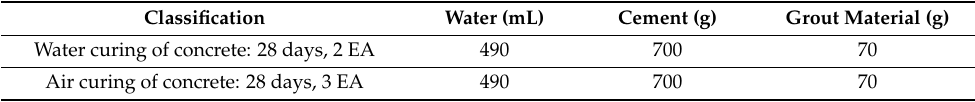
Table 5. Mixing ratio for lab pull-out